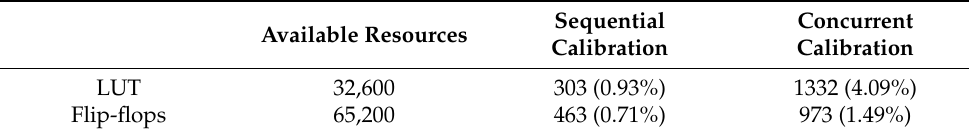
Figure 15. Comparison between the sequential and the parallel algorithm. Table 3. XC7A50T Artix-7 FPGA logic resources (available and